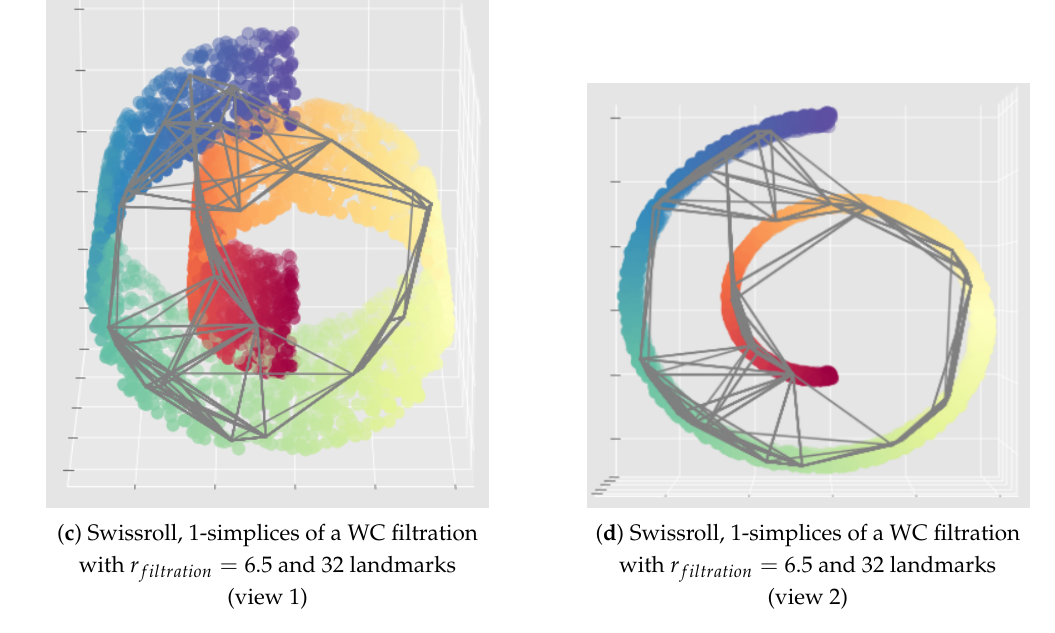
Figure A2. Examples of bad witness complexes (WC) constructions for the Swissroll. On the top ( a , b ), the built witness complex is bad because it has two connected components instead of one. On the bottom ( c , d ), the witness complex is bad again, but because the radius filtration chosen is too high.